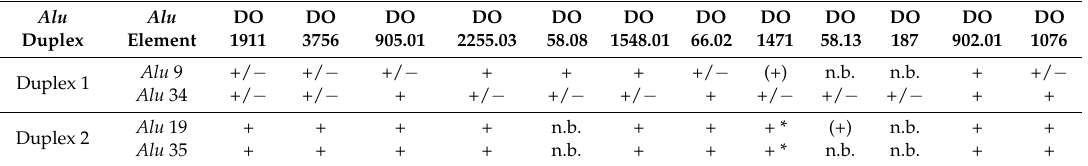
Table 2. Results for both duplex PCRs. “+” indicates that internal band was amplified. “ − ” represents the absence situation. No amplification success is displayed with “n.b.”. Results in parentheses were amplified only once.